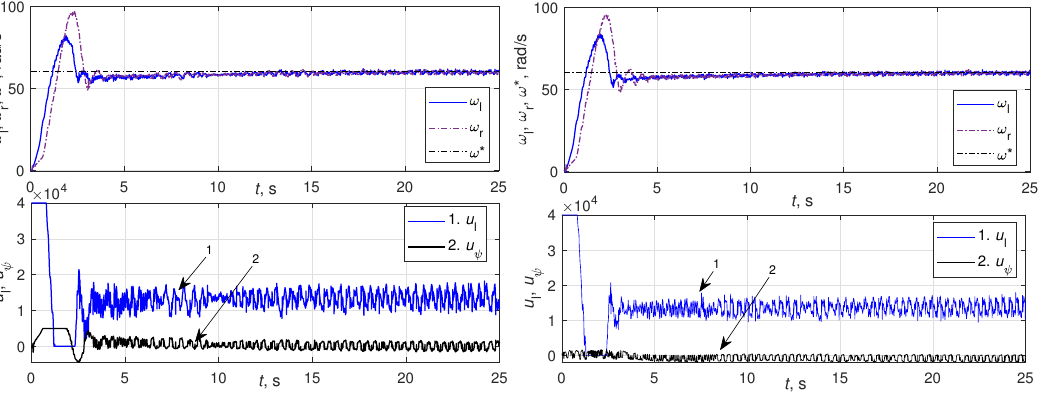
Figure 3. Experiment. ω l ( t ) , ω r ( t ) , ω ∗ ( t ) ( upper plot ) and control actions u l ( t ) , u ψ ( t ) ( lower plot ) time histories for ψ ∗ = 0. Linear error ( left column ), sine-modification ( right column ). The experimental results for ψ ∗ = 0 are shown in Figures 3–5. It is seen from Figure 3 that after some transient with the settling time approximately equal to 5 s, both the left and the right rotor velocities ω l ( t ) , ω r ( t ) are closed to the reference value ω ∗ = 60 s − 1 . The